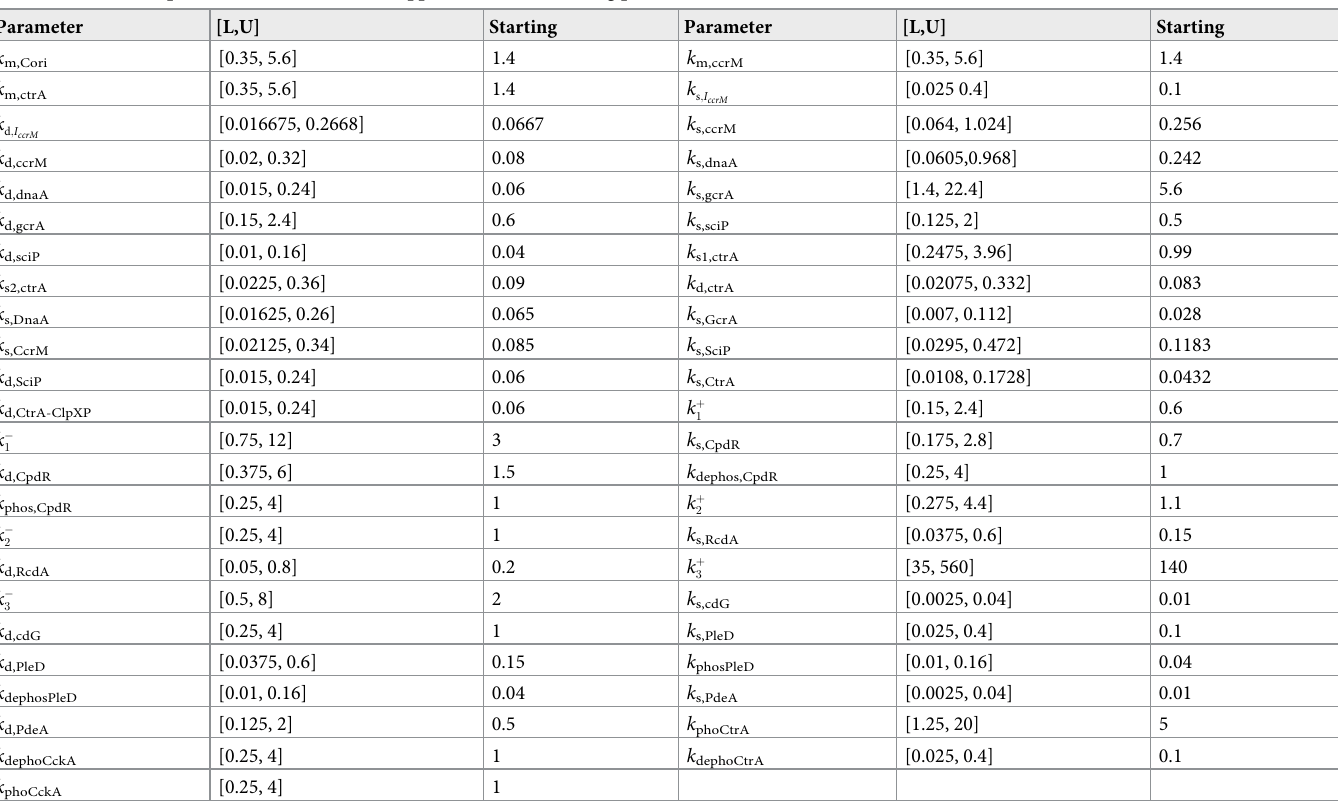
Table 4. Parameter optimization with lower and upper bounds and starting point.